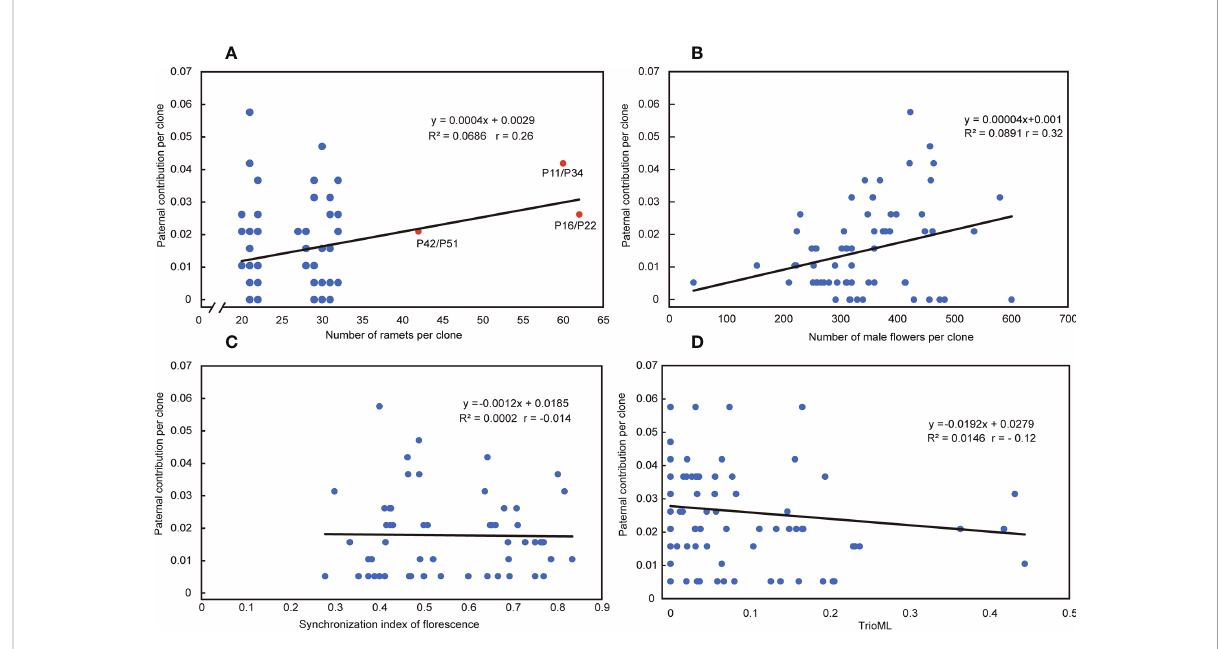
FIGURE 6 Relationship between reproductive factors and paternal contribution. (A) Relationship between the number of ramets per clone and paternal contribution per clone in the seed orchard. Red dots represent that pairwise comparisons were considered clones. (B) Relationship between the number of male fl owers per clone and paternal contribution per clone in the seed orchard. (C) Relationship between the synchronization index of fl orescence (S) and the paternal contribution per clone in the seed orchard. (D) Relationship between the T (TrioML) and the paternal contribution per clone in the seed orchard. R2= R-Squared; r= Pearson correlation coef fi